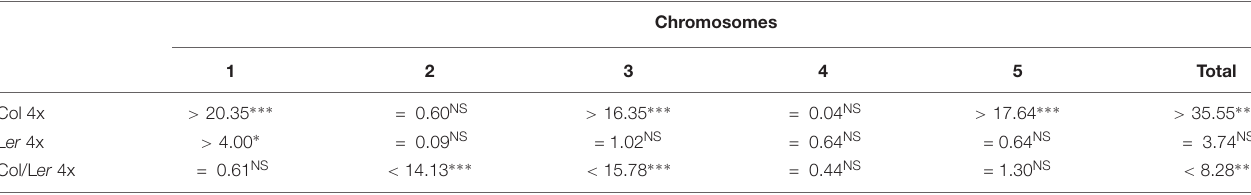
TABLE 3 | Chi-square test values ( χ 2 1 ) testing goodness of fit to 2:1 ratio of multivalents: bivalent pairs for the different chromosomes (1–5) in PMCs from Col, L er and Col/L er autotetraploid plants.